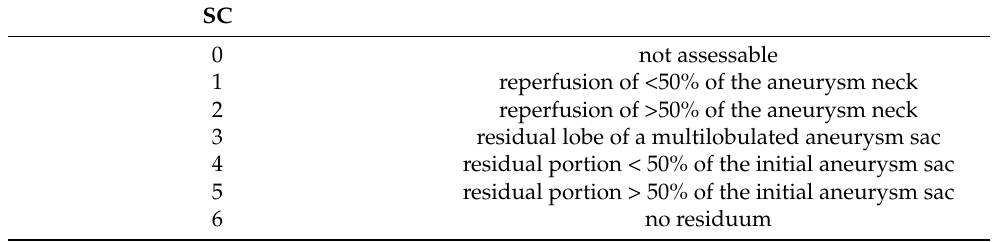
Table 2. Sindou’s classification (SC) for intracerebral aneurysms treated via surgical clipping. SC